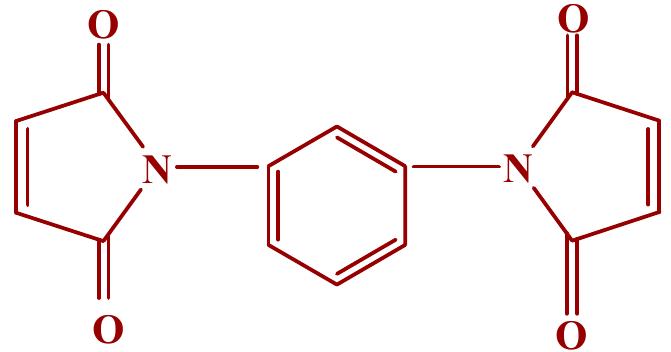
Figure 1. N, N’-meta phenylene